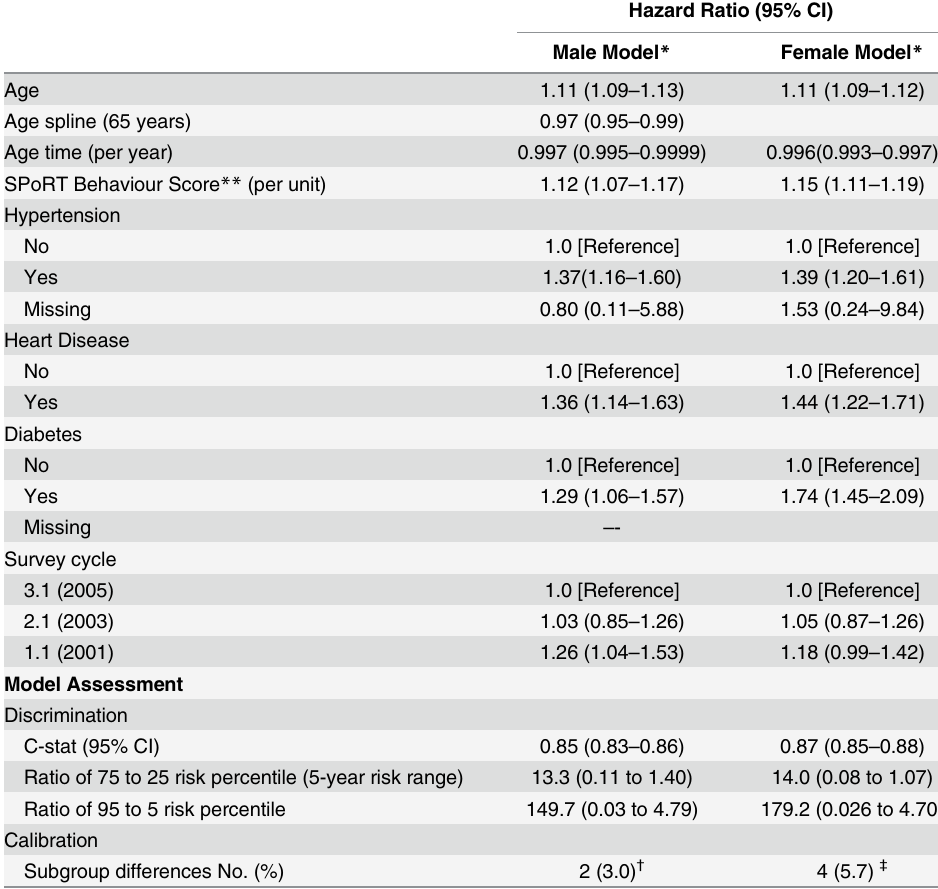
Table 2. Stroke Population Risk Tool (SPoRT) –